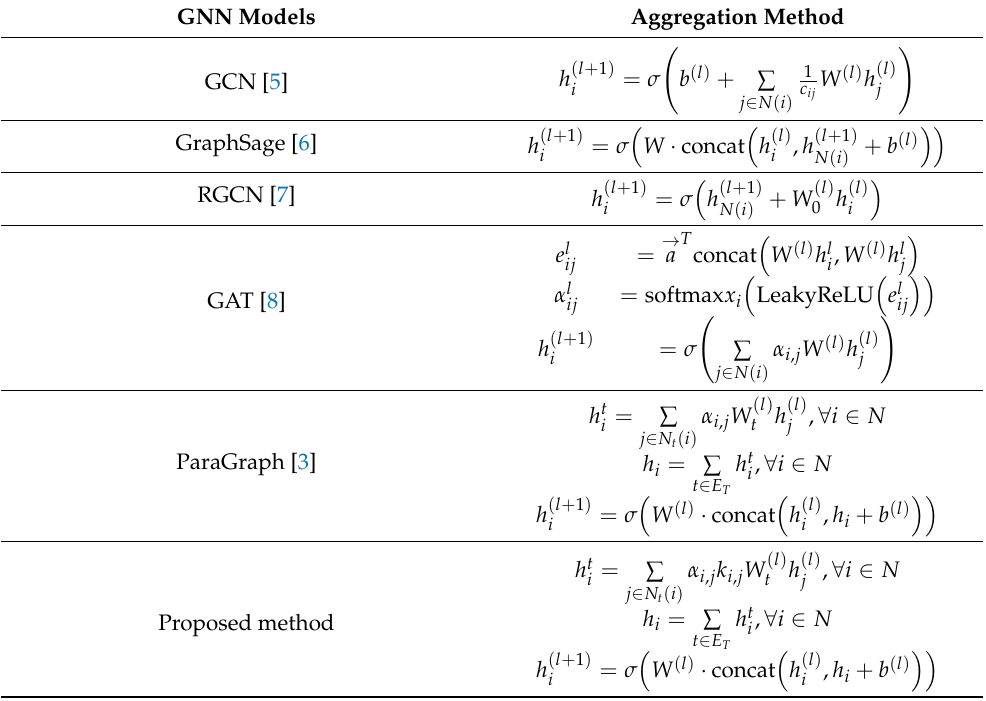
Table 2. Aggregation methods of the present GNN models and the proposed model. GNN